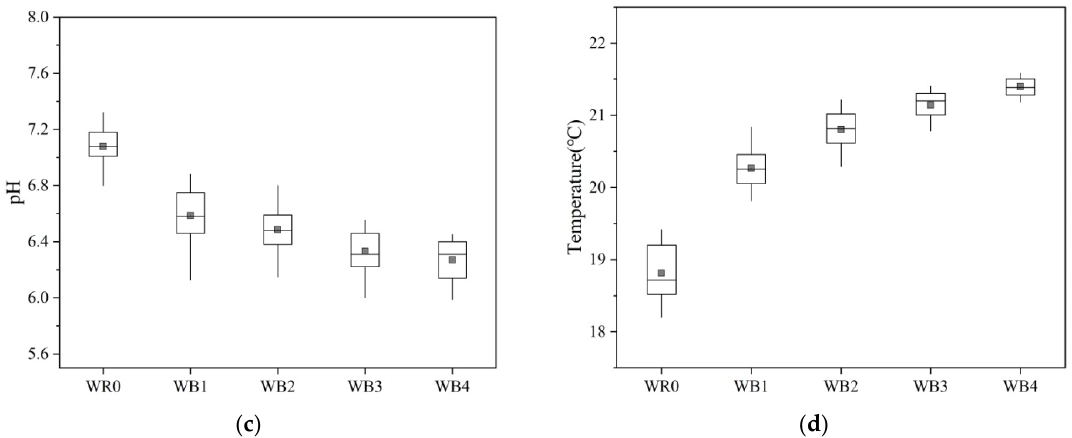
Figure 9. Spatial variations of eco-environmental factors along the transect: ( a ) dissolved oxygen, DO; ( b ) dissolved organic carbon, DOC; ( c ) pH; ( d ) temperature.